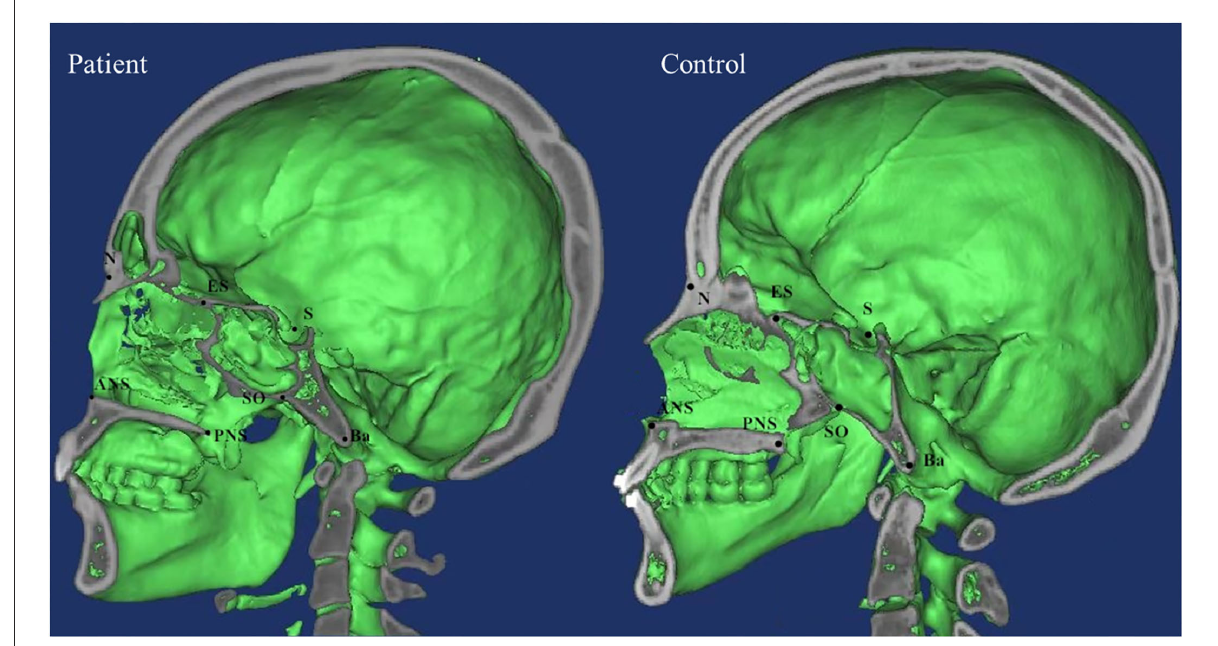
FIGURE2 The anatomical landmarks were shown on the computed tomographic scans (sagittal